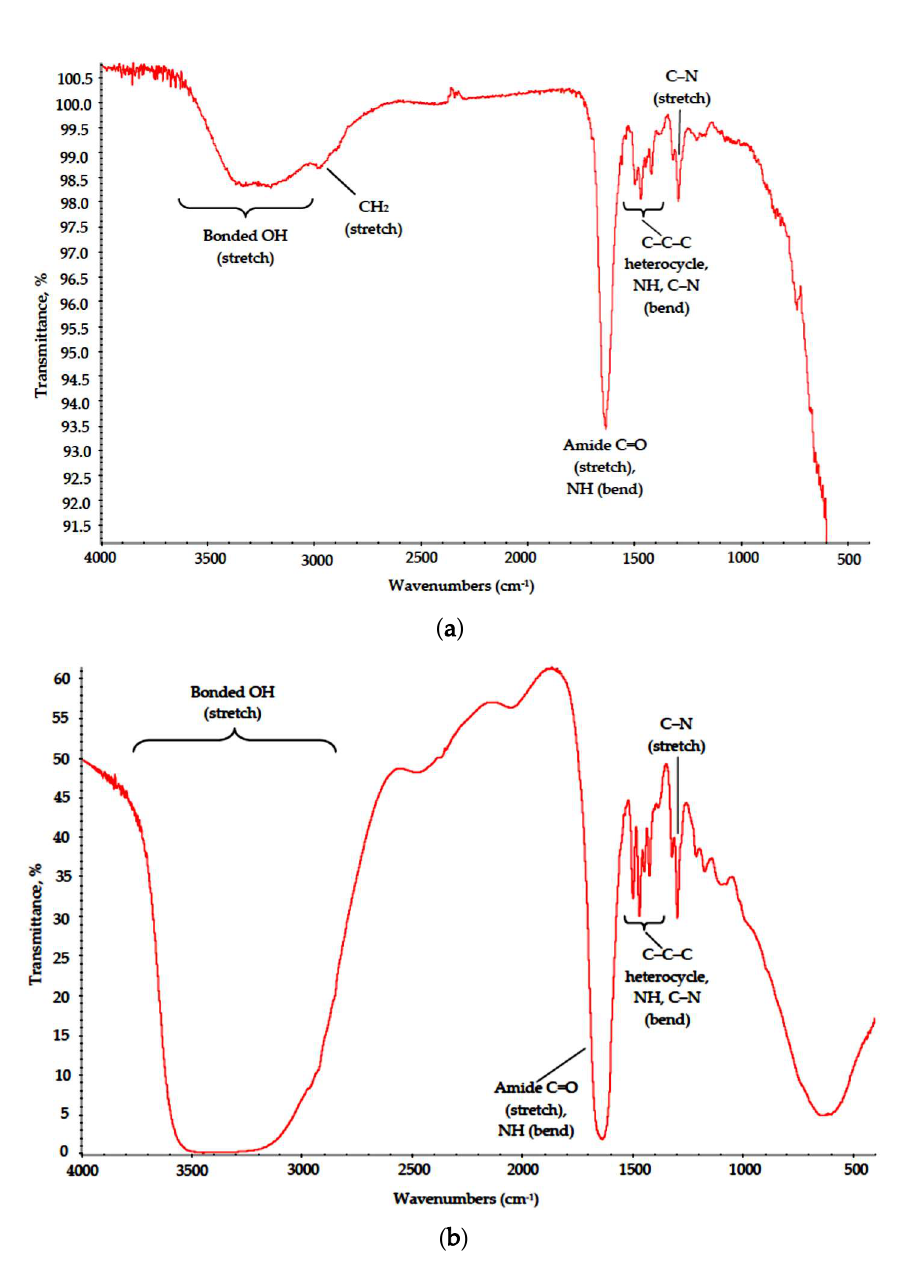
Figure 8. Dried products in the Na-CMC–MAY system: (a) phase composition; (b)